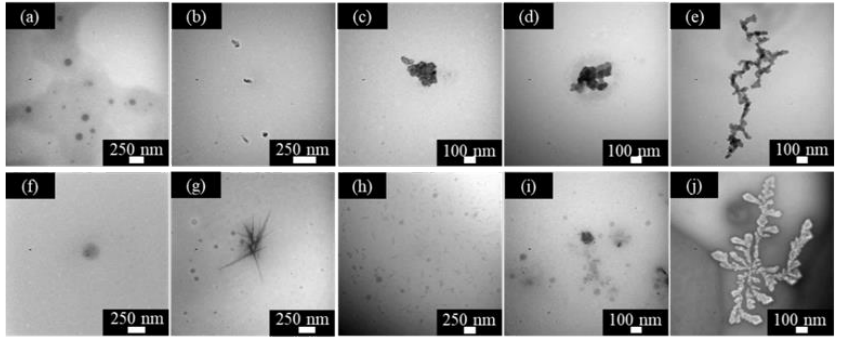
Figure 4. TEM imagines of DPM at different concentration and pH values—pH = 1.42: ( a ) 2 CMC and ( f ) 5 CMC; pH = 3.04: ( b ) 2 CMC and ( g ) 5 CMC; pH = 6.04: ( c ) 2 CMC and ( h ) 5 CMC; pH = 9.06: ( d ) 2 CMC and ( i ) 5CMC; pH = 10.08: ( e ) 2 CMC and ( j ) 5CMC.